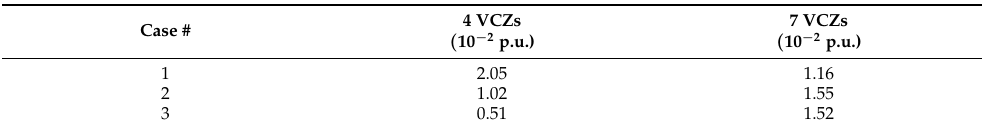
Table 6. Voltage performance index for the partitioning in four VCZs and seven VCZs provided by solving problem